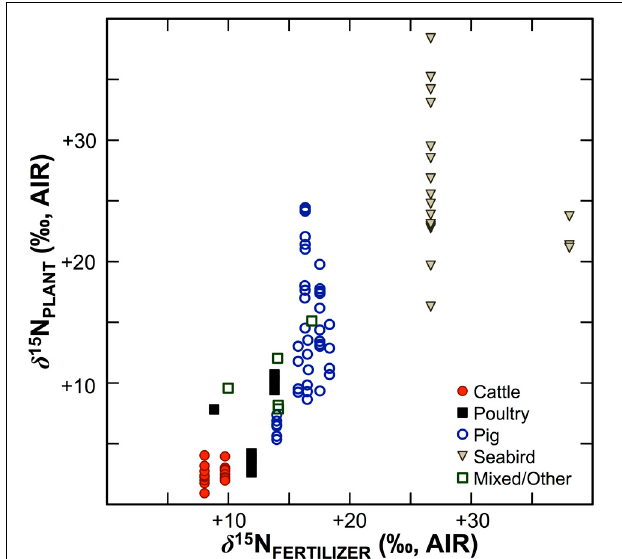
FIGURE 5 | Bivariate plot of fertilizer δ 15 N vs. plant δ 15 N. Generally, plant δ 15 N increases with fertilizer δ 15 N, although there is considerable variation, which can be ascribed to the relative availability of N compounds in the fertilizer, the rate and duration of application, and interspecific differences in plant N acquisition strategies. Data are compiled from experimental studies (Choi et al., 2002, 2003; Watzka et al., 2006; Yun et al., 2006; Lim et al., 2007; Nakano and Uehara, 2007; Yun and Ro, 2009; Rapisarda et al., 2010; Szpak et al., 2012a,b, 2014; Yuan et al., 2012; Zhou et al.,